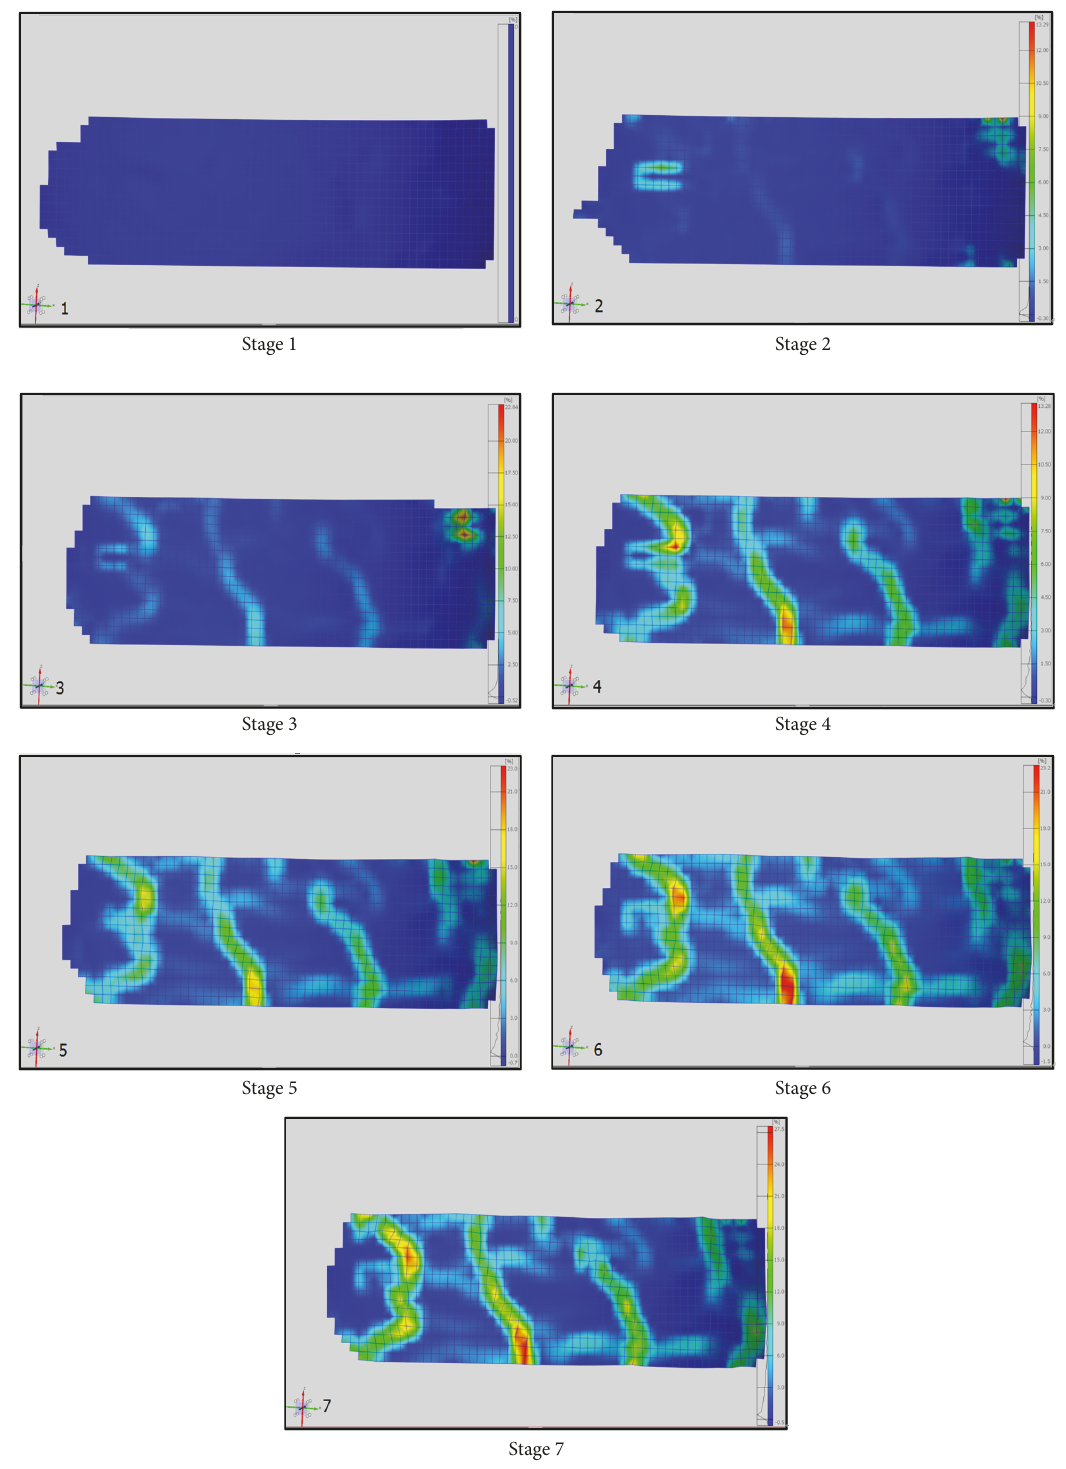
Figure 7: Evolutionary trends of the major strain of the mudded weak interlayer specimen, under uniaxial